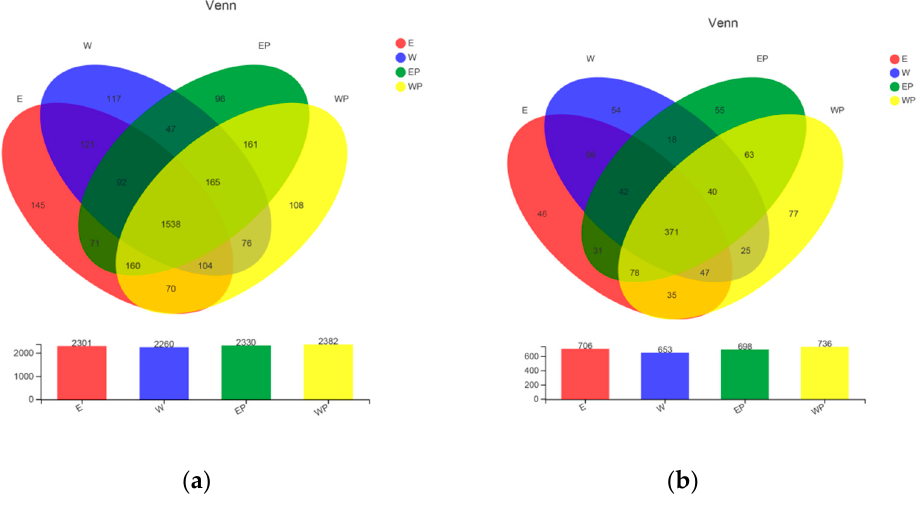
Figure 4. Venn diagram of OTUs in four samples. ( a ) Bacteria; ( b ) fungi. The bacterial alpha diversity is shown in Table 2. Compared with the EP and